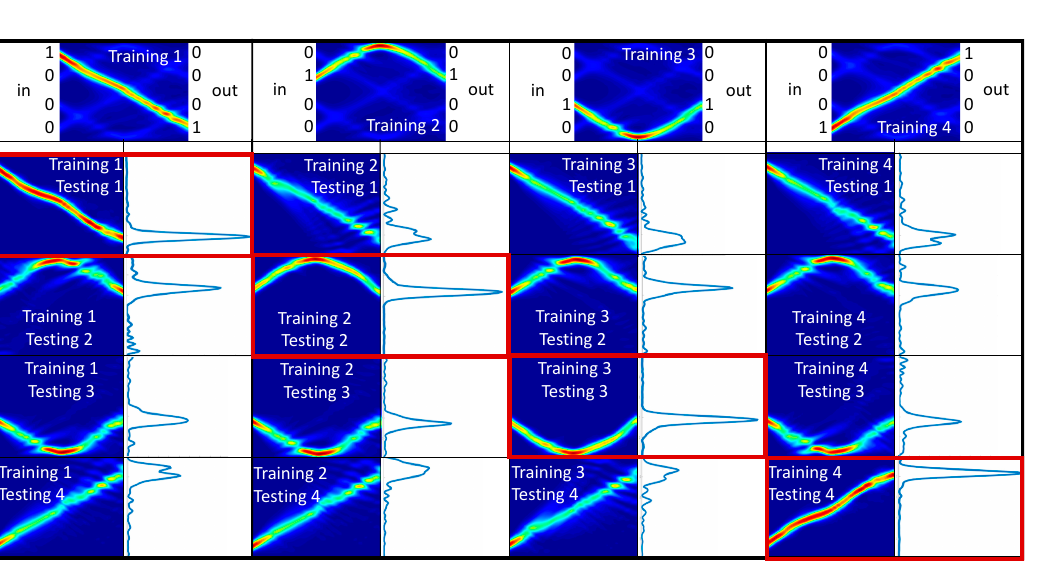
Figure 9. Training and testing phases are reported for 1-digit, 4-bit numbers. In the first raw, the training phases are reported. In the following raws, the testing experiments are reported. Those for which training and testing numbers coincide are framed in red.